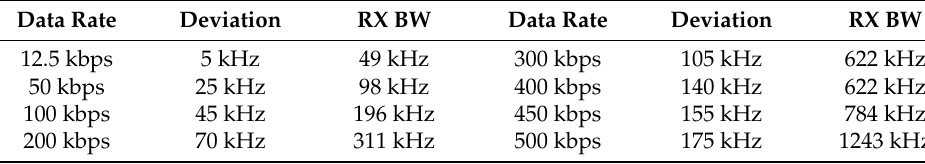
Table 1. Parameters of each data rate. Table 2. Average